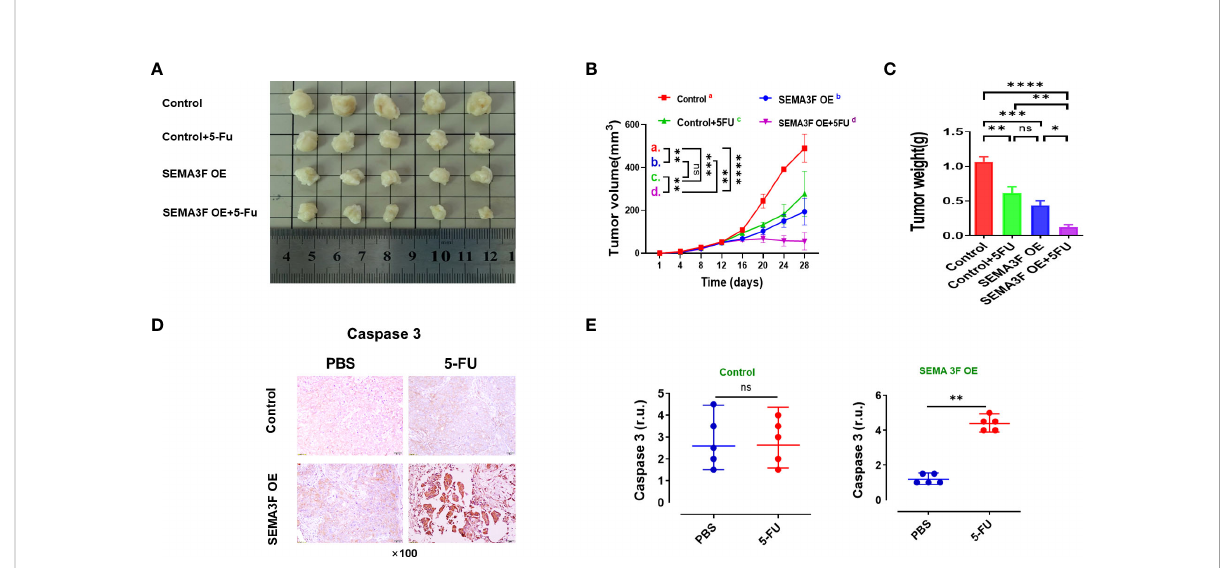
FIGURE 3 SEMA3F overexpression enhanced the sensitivity of CRC cells to 5-Fu in vivo . (A) Mice were subcutaneously injected with LoVo cells (SEMA3F OE LoVo cells for the test groups, LoVo cells for the control groups) in the left groin. Two weeks after tumor cell inoculation, animals were treated with 5-Fu or PBS by peritumoral injection every 48 h for 2 weeks.Then the mice were sacri fi ced, and the tumors were collected. (B, C) Statistical analysis of tumor volume and weight in the SEMA3F OE group and control group. (*P<0.05, **P<0.01, ***P<0.001, ****P<0.0001). (D) Immunohistochemical staining of caspase3 in CRC tissues from the SEMA3F OE groups and control groups treated with 5-Fu or PBS. (E) Statistical analysis of caspase3 in CRC tissues from the SEMA3F OE groups and control groups treated with 5-Fu or PBS (**P<0.01) ns, Not Statistically Signi fi